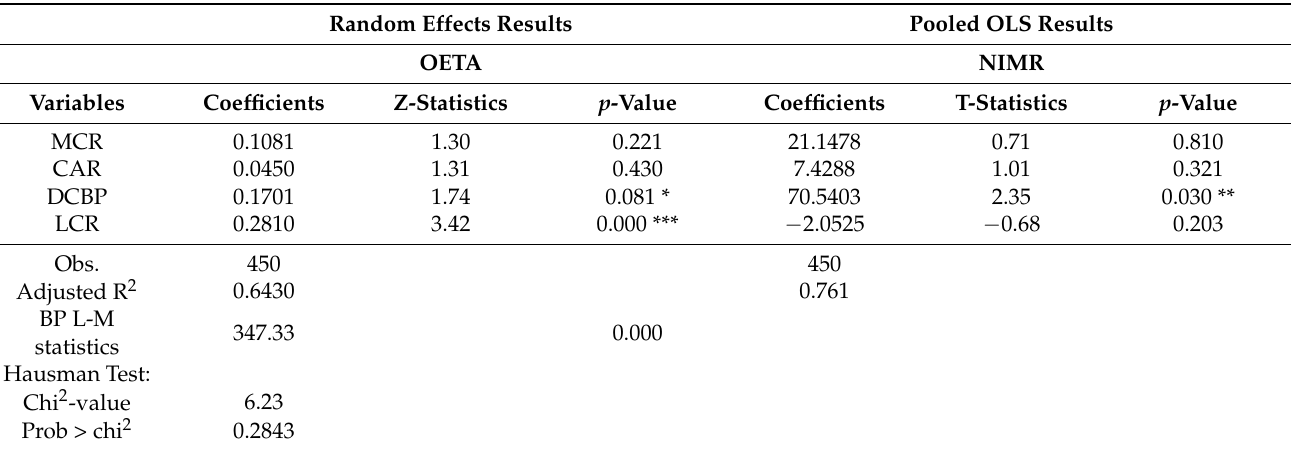
Table 4. Random effects and pooled OLS regression